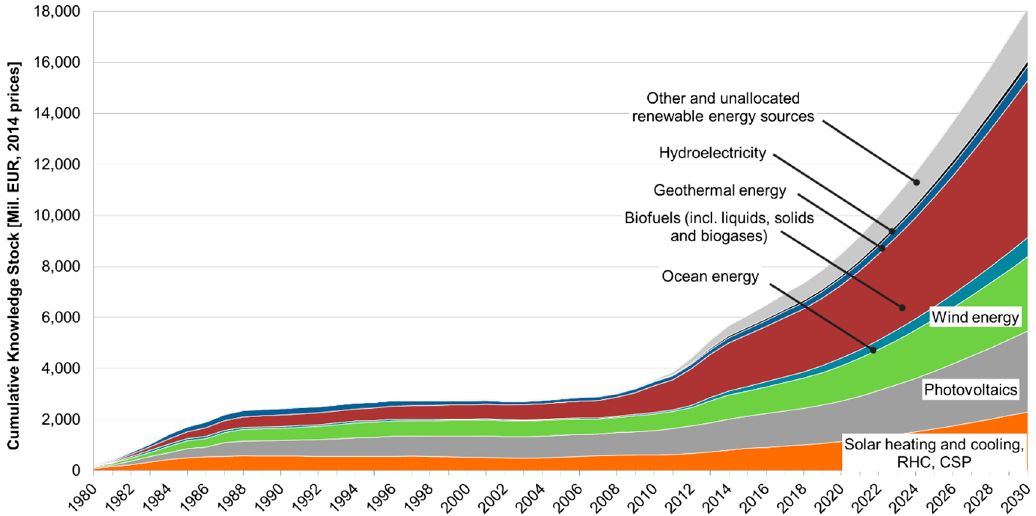
Figure 5. Cumulative RES knowledge stock by public R&D expenditures of the EU MS (Mil. EUR,